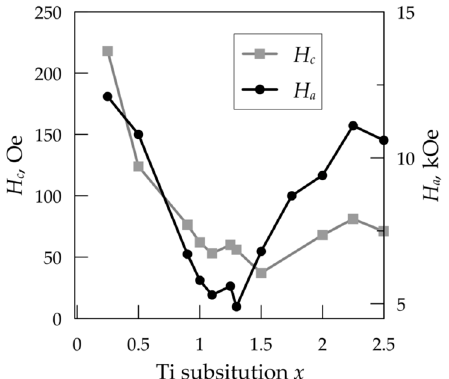
Figure 5. The anisotropy fields H a calculated from LAS, and coercivity H c for the composite samples of BaFe 12 − x Ti x O 19 plotted against the volume fraction. Lines are guides for eyes.